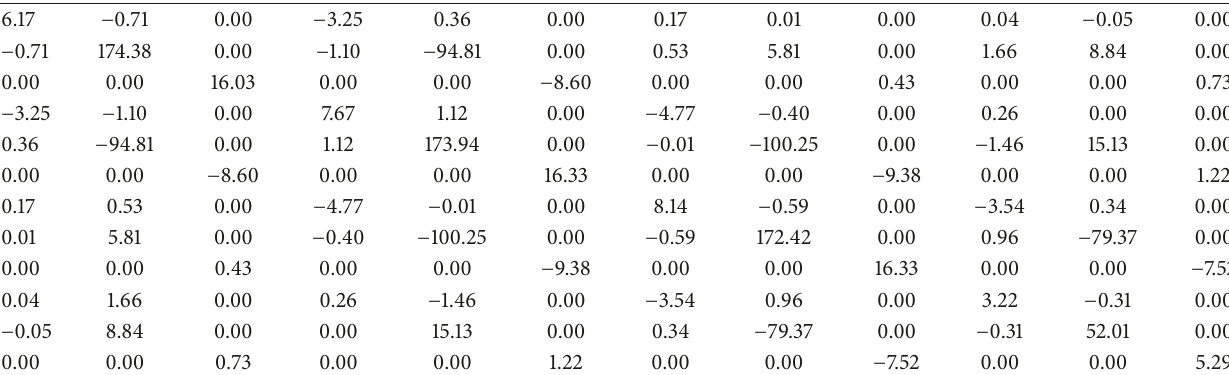
Table 7: Structure A stiffness matrix ( ⋅ 10 5